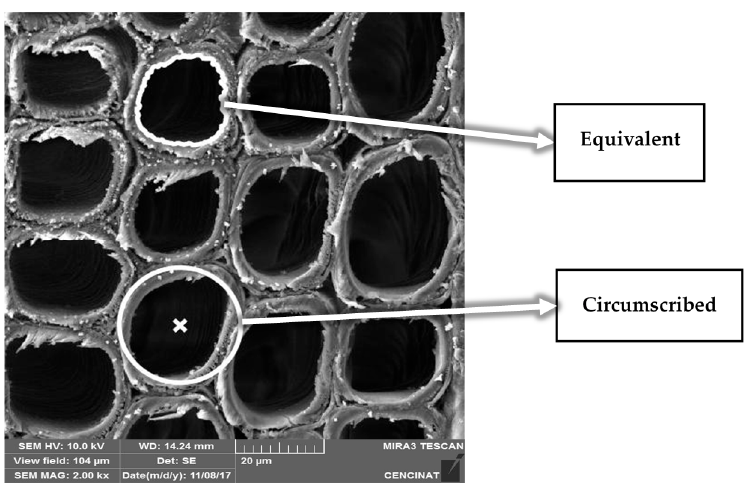
Figure 1. Microphotograph of a cypress sample showing a group of longitudinal tracheids where, for visual understanding, one equivalent and one circumscribed circle is depicted. For this specific example, 12 cypress tracheids were analysed in terms of density, area, roundness and sphericity.